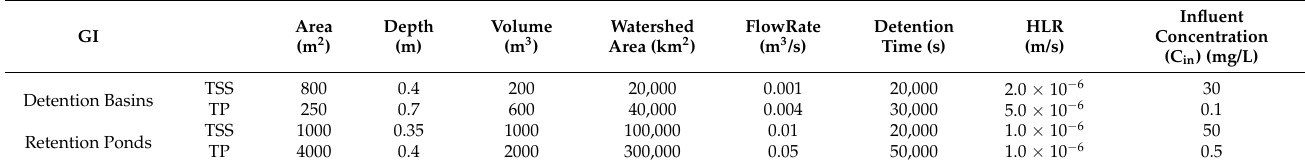
Table 1. Stratified sampling values for each